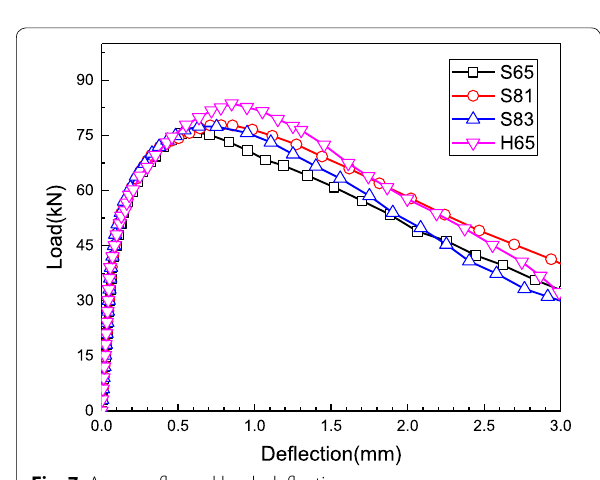
Fig. 7 Average flexural load–deflection